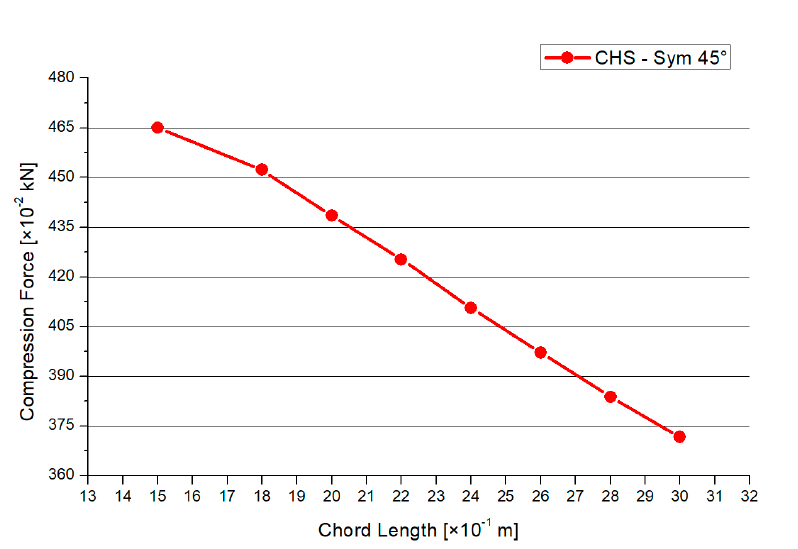
Figure 11. Results—Maximum Compression Force.